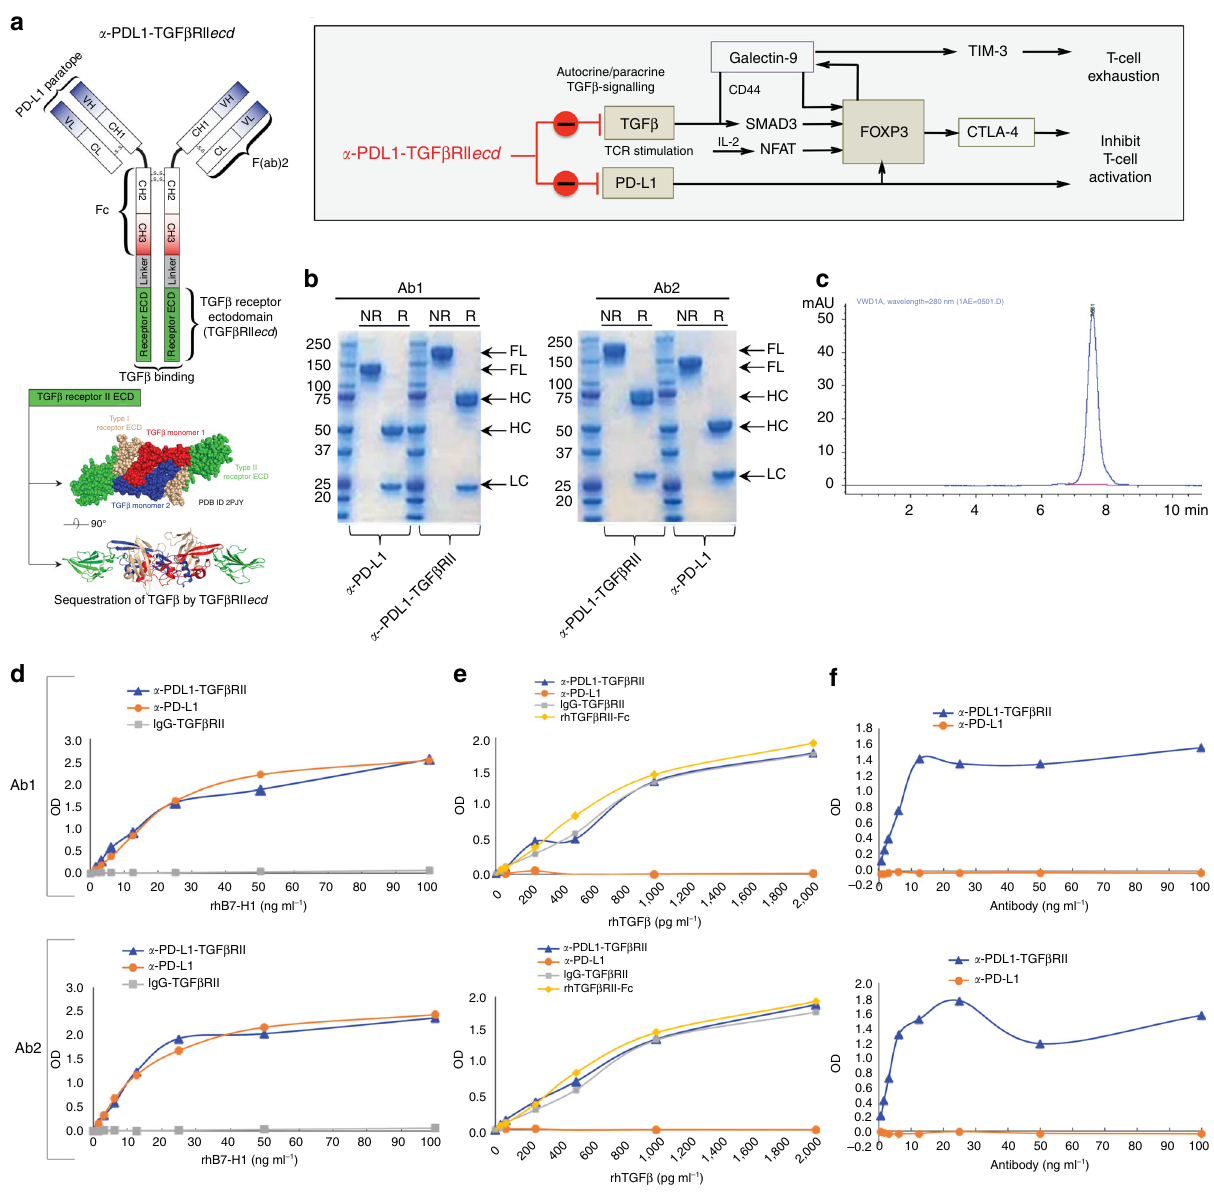
Fig. 6 Design and bifunctional target binding ability of anti-PDL1-TGF β RII. a Schematic representation of PD-L1 and TGF β entrained independent and cooperative mechanisms of immune tolerance. Schematic structure and targets of a -PDL1-TGF β RII are shown. a -PDL1-TGF β RII was designed by fusing the C terminus of the heavy chain of a human a -PD-L1 antibody with a ligand-binding sequence of the extracellular domain of TGF β Receptor II (TGF β RII ECD) via a fl exible linker peptide, (GGGGS) 3. b SDS-PAGE under non-reducing (NR) and reducing (R) conditions was used to compare the full-length, heavy chain and light chain of a -PDL1-TGF β RII and a -PD-L1 antibody. Figure shows the results of SDS-PAGE analyses of each of two separate a -PDL1-TGF β RII Y- traps (Ab1 and Ab2) and their respective human a -PD-L1 antibody (atezolizumab and avelumab). c SEC-HPLC analysis of puri fi ed a -PDL1-TGF β RII; d ELISA showing the comparative ability of a -PDL1-TGF β RII and a -PD-L1 antibody to bind PD-L1. Biotinylated recombinant human PD-L1 (rh B7-H1-biotin; 0 – 100 ng ml − 1 ) was added to plates coated with a -PDL1-TGF β RII or a -PD-L1 antibody (1 μ g ml − 1 ), followed by detection with HRP-Avidin. Plates coated with non- speci fi c IgG-TGF β RII showed no binding to PD-L1 and served as a negative control to analyze the binding ability of the test samples. e ELISA showing the comparative ability of a -PDL1-TGF β RII and a -PD-L1 antibody to bind TGF β . Recombinant human TGF β (rhTGF β 1; 0 – 2,000 pg ml − 1 ) was added to plates coated with a -PDL1-TGF β RII or a -PD-L1 antibody (1 μ g ml − 1 ), which was detected by biotinylated a -TGF β 1 and HRP-Avidin. Plates coated with nonspeci fi c IgG-TGF β RII and rhTGF β RII-Fc served as positive controls to analyze the binding ability of the test samples to TGF β . f ELISA showing the ability of a -PDL1- TGF β RII to simultaneously bind both PD-L1 and TGF β . Anti-PDL1-TGF β RII or a -PD-L1 antibody (0 – 100 ng ml − 1 ) was added to PD-L1-Fc coated plates (1 μ g ml − 1 ), followed by rhTGF β 1 (100 ng ml − 1 ) that was detected by a biotinylated anti-human TGF β 1 antibody. For d – f , the data show the optical density (OD) values (mean of three replicate wells for each assay condition) from a representative of two independent